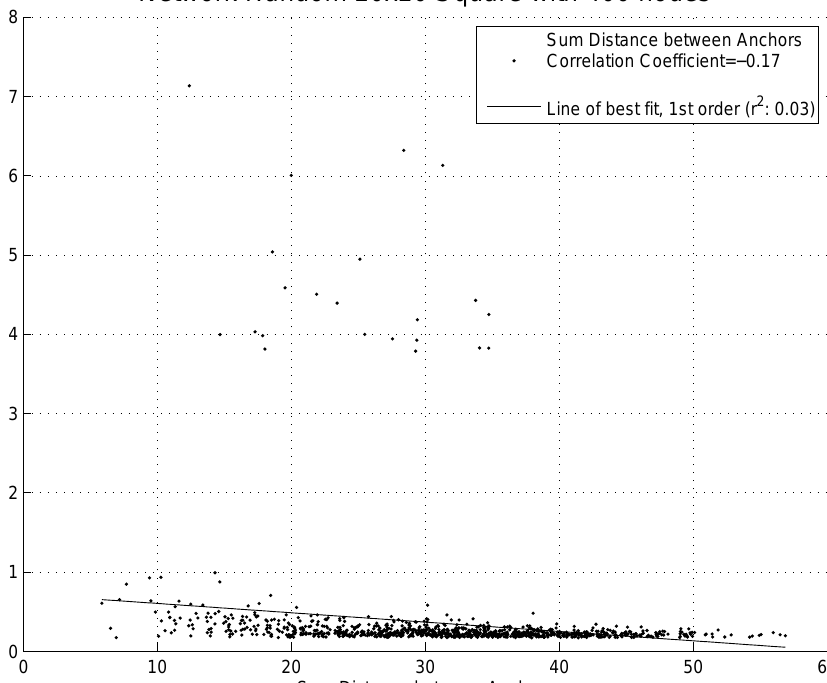
Figure 2. Sum of distance between anchors vs . localization